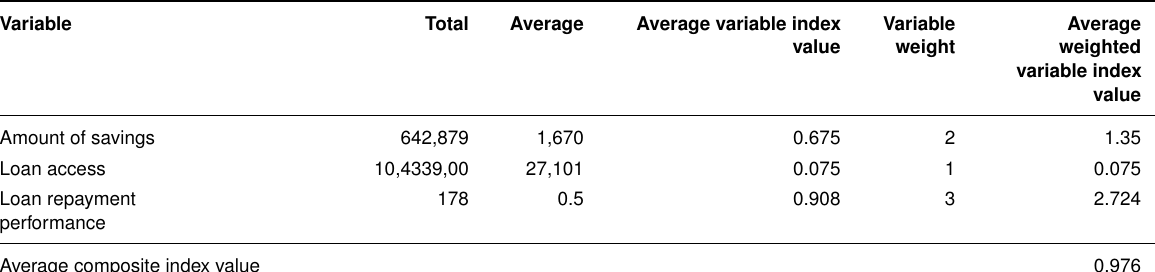
Table 5. Calculation of informal microfinance performance index.